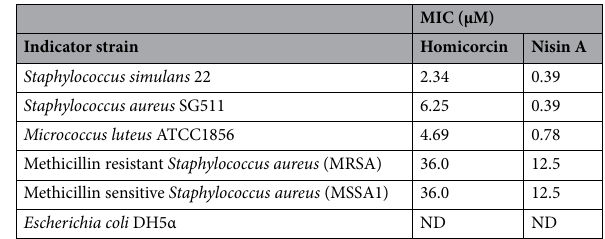
Table 4. Specific activities of homicorcin and nisin A. ND is for indicator growth inhibition not detected at the highest concentration of peptides used.